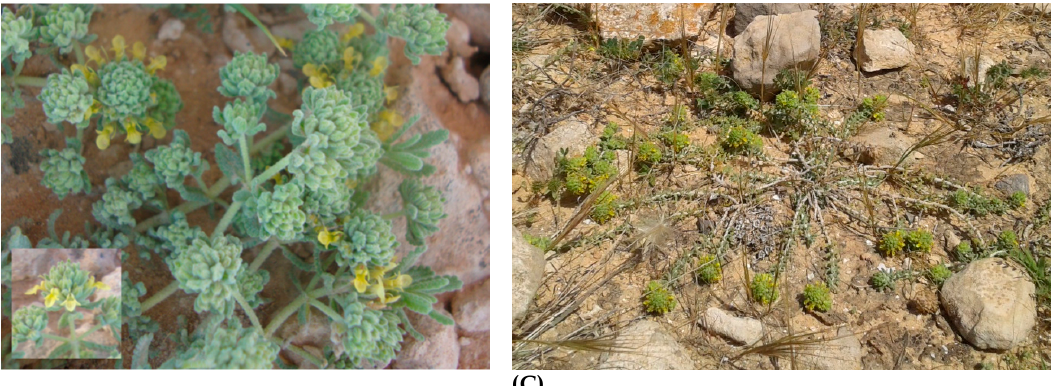
Figure 6. Three top-evaluated Tunisian endemic plants of Lamiaceae family, in terms of maximum possible score, achieved regarding their agro-alimentary potential. ( A ): Marrubium aschersonii (Photo: G. Dakhlia), ( B ): Teucrium alopecurus (Photo: Z. Ghrabi-Gammar), ( C ): Teucrium luteum subsp. gabesianum (Left photos: Z. Ghrabi-Gammar; right photo: S. Bourgou). For these plants, propagation material has been collected from the wild to allow ex-situ conservation and propagation-cultivation trials at the Institute of Plant Breeding and Genetic Resources, Hellenic Agricultural Organization Demeter.